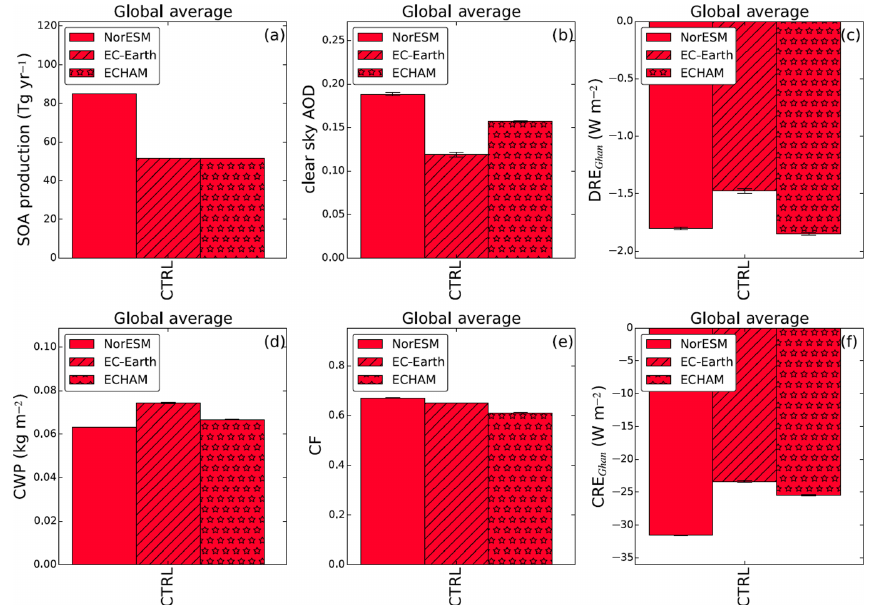
Figure 2. Bar plots of the total yearly global SOA production and the yearly averaged aerosol optical depth (AOD), direct radiative effect (DRE Ghan ), cloud water path (CWP), cloud fraction (CF) and cloud radiative effect (CRE Ghan ) for all three models for the CTRL experiment. The error bars denote the standard error of mean of the yearly